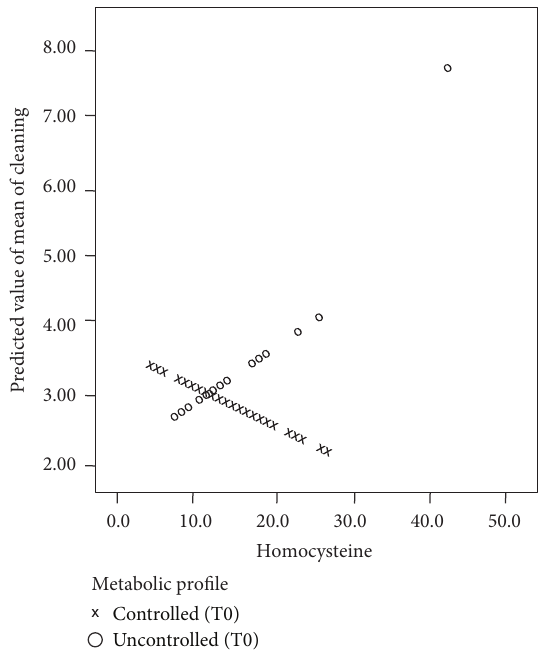
Figure 3: Predicted values of mean of cleaning by homocysteine levels and metabolic profile.